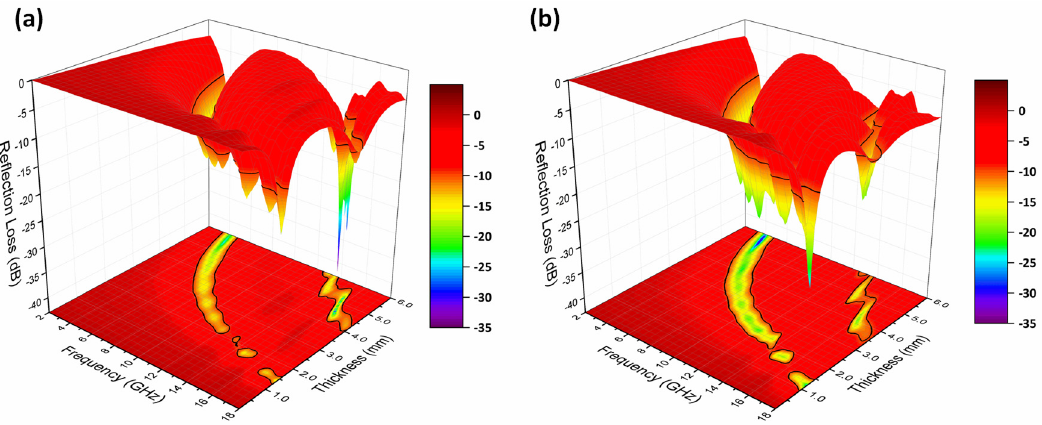
Figure 13. Three-dimensional representation of reflection loss of ( a ) Fe nanowires, ( b ) Fe@PANI-90/10 in different thicknesses.